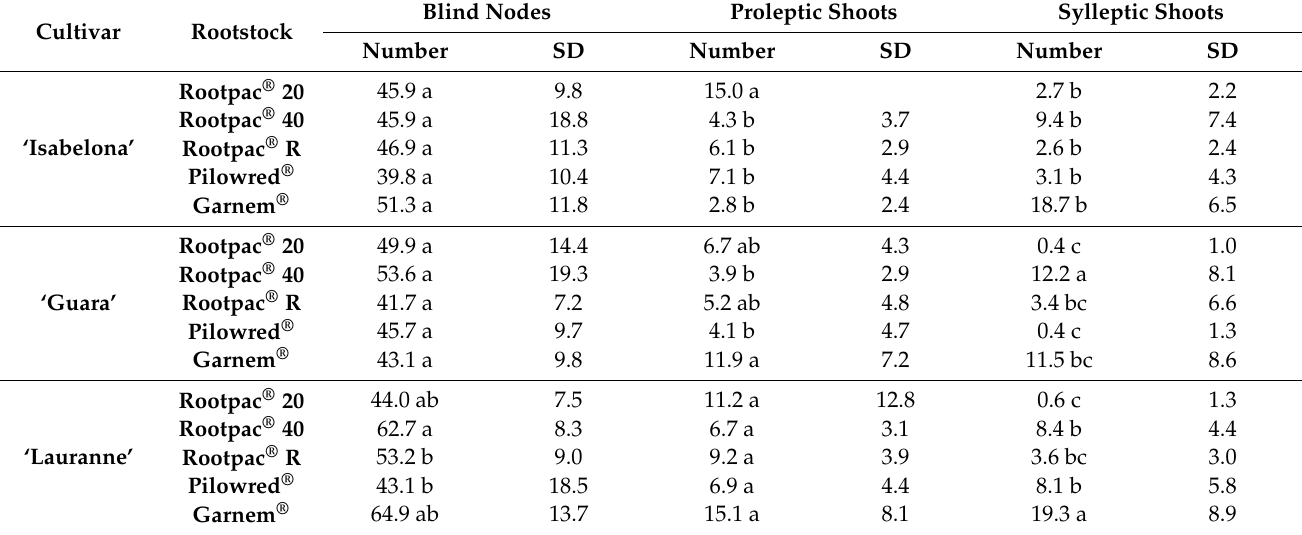
Table 2. Mean number of blind nodes, proleptic shoots, and sylleptic shoots on two-year-old branches of 15 scion/rootstock combinations of almond